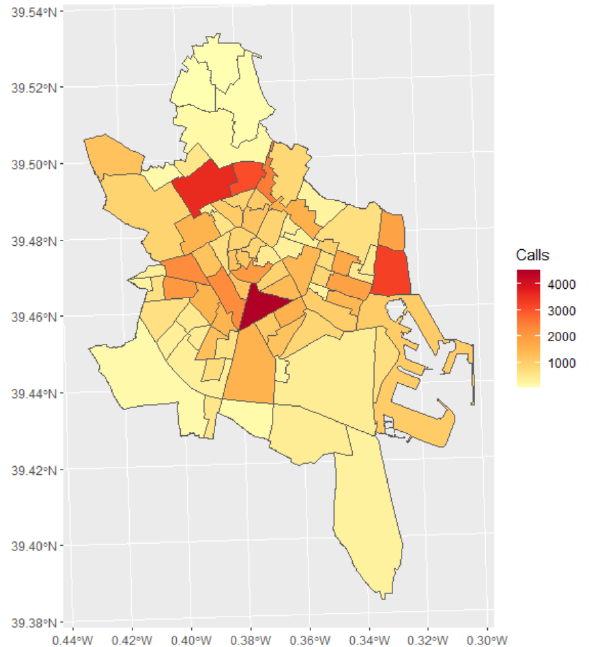
Figure 2. Map of total number of calls per district in